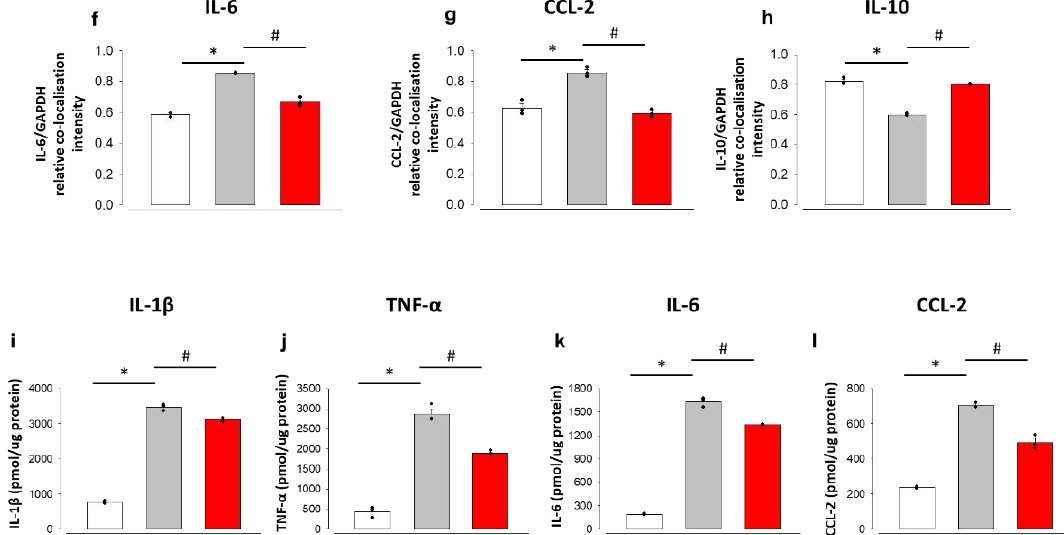
Figure 3. MSC-derived EVs reduce NLRP3-inflammasome, and the expression and release of pro- inflammatory cytokines, in mouse astrocytes. ( a ) Representative WB immunoreactive bands for NLRP3 in WT astrocytes, SOD1 G93A astrocytes and EV-treated SOD1 G93A astrocytes. ( b ) Quantitative representation of NLRP3 expression, normalized to GAPDH. Data are presented as means ± SEM of n = 5 independent experiments; statistical significance for p < 0.05 (* vs. WT and # vs. SOD1 G93A astrocytes; p = 0.008 vs. WT astrocytes; p = 0.02 vs. untreated SOD1 G93A astrocytes; F (2,10) = 9.562; one-way ANOVA, followed by Bonferroni post hoc test). ( c ) Representative images for GAPDH (red fluorescence), TNF- α (green fluorescence), and DAPI (blue fluorescence), in WT astrocytes, SOD1 G93A astrocytes and EV-treated SOD1 G93A astrocytes. Scale bar: 100 µm. ( d – h ) Quantitative representation of fluorescence intensity (see legend to Figure 2 for details) for ( d ) TNF- α , ( e ) IL-1 β , ( f ) IL-6, ( g ) CCL2, and ( h ) IL-10, in WT astrocytes, untreated SOD1 G93A astrocytes and EV-treated SOD1 G93A astrocytes. Data are presented as means ± SEM of n = 3 independent experiments, run in triplicate; statistical significance for p < 0.05 (* vs. WT and # vs. SOD1 G93A astrocytes; F (2,6) = 40.686, p < 0.001; F (2,6) = 443.910, p < 0.001; F (2,6) = 174.847, p < 0.001; F (2,6) = 50.196, p < 0.001; F (2,6) = 256.549, p < 0.001 for TNF- α , IL-1 β , IL-6, CCL2, and IL-10, respectively, in SOD1 G93A vs. WT; astrocytes; p = 0.002, p < 0.001, p < 0.001, p < 0.001 and p < 0.001 for TNF- α , IL-1 β , IL-6, CCL2, and IL-10, respectively, in EV-treated SOD1 G93A vs. untreated SOD1 G93A astrocytes; one-way ANOVA, followed by Bonferroni post hoc test). ( i – l ) ELISA quantification of cytokines (pmol/ug of proteins), for ( i ) IL-1 β , ( j ) TNF- α